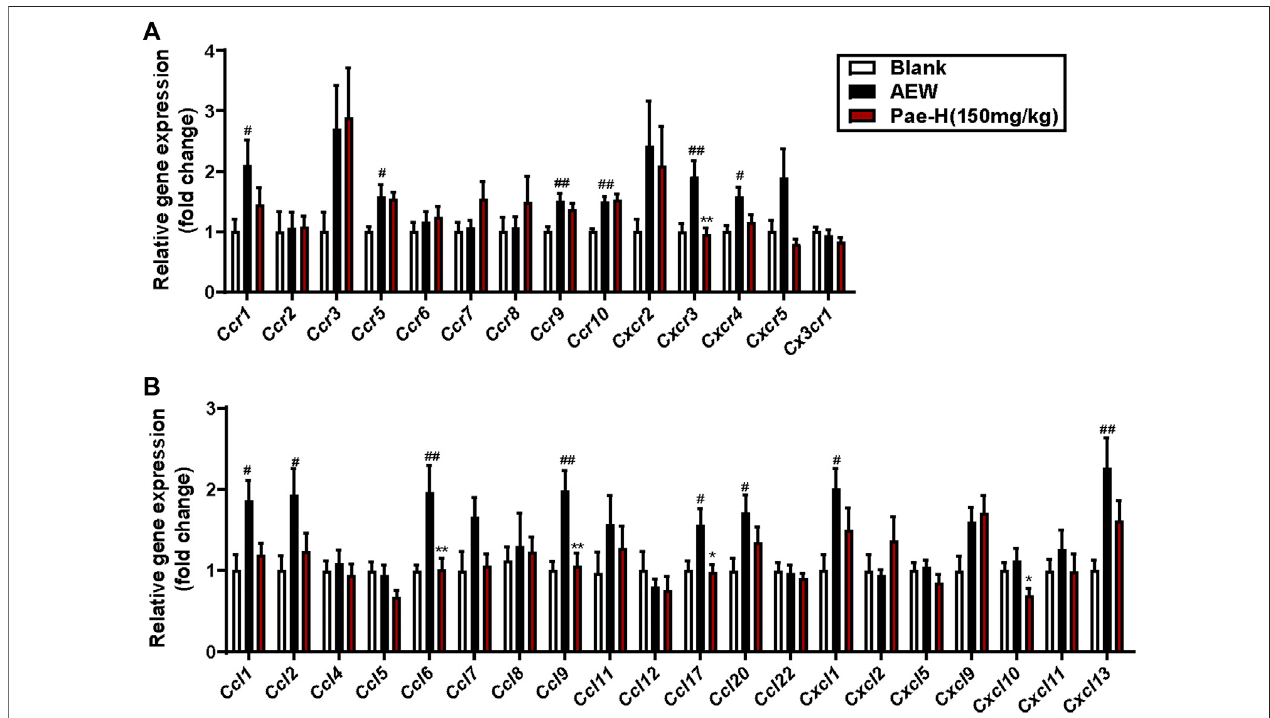
FIGURE 4 | The effects of paeonol on the expression of chemokine receptors and ligands in the spinal cords. The increased mRNA levels of chemokine receptor Cxcr3 (A) and chemokines including Ccl6 , Ccl9 , and Ccl17 (B) in the spinal cord of AEW mice were decreased by paeonol application. Data were expressed as mean ± SEM. # p < 0.05, ## p < 0.01, ### p < 0.001, compared to the blank group; p p < 0.05, pp p < 0.01, compared to the AEW model group ( n (cid:1) 4 – 8 each